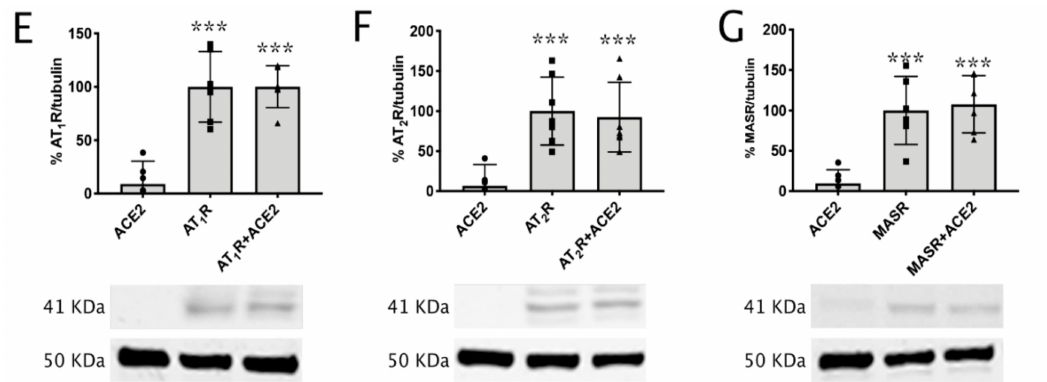
Figure 5. RAS receptors regulate cell surface expression of ACE2. ( A ) Immunocytochemistry assays were performed in HEK-293T cells expressing ACE2-eGFP together with AT 1 R-RLuc, AT 2 R-RLuc, or MasR-RLuc and activated with the respective agonists. Cells that expressed each RAS receptor were treated with their respective selective agonist. ACE2-eGFP expression was evaluated quantitatively via green fluorescence. The RLuc-containing receptors were detected by an anti-RLuc primary antibody and a secondary Cy3-conjugated anti-mouse antibody (red-staining). Colocalization is shown in yellow. Scale bar = 10 µ m. ( B – G ) Biotinylation experiments were performed in HEK-293T cells transfected with cDNA encoding AT 1 R-RLuc (1 µ g; B , E ), AT 2 R-RLuc (1 µ g; C , F ) or MasR-RLuc (1 µ g; D , G ) with or without 0.8 µ g of ACE2-HA cDNA. Images from a representative experiment are shown (expansion of the image areas in Figure 5 and position of the MW from this representative experiment appear in Supplementary Figure S1). Immunoreactive bands from 6 independent experiments were quantified. Values presented are the mean ± SD. One-way ANOVA followed by Bonferroni’s multiple comparison posthoc tests were used for statistical analysis; * p < 0.05, *** p < 0.001 vs. ACE2-HA